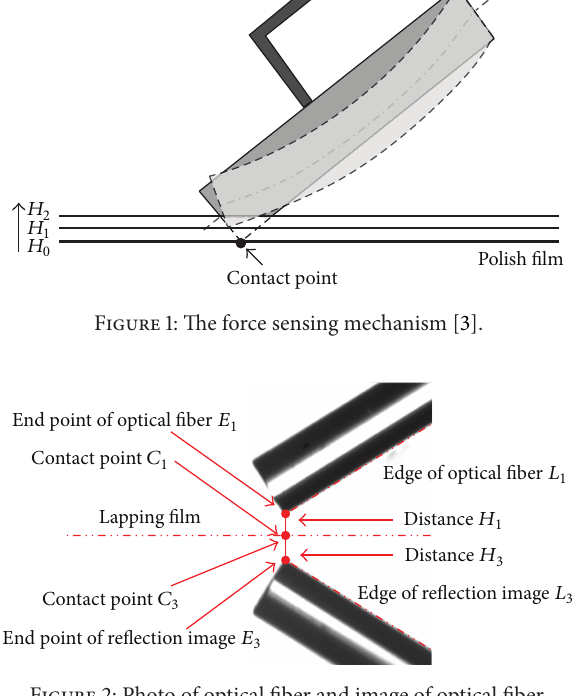
Figure 2: Photo of optical fiber and image of optical